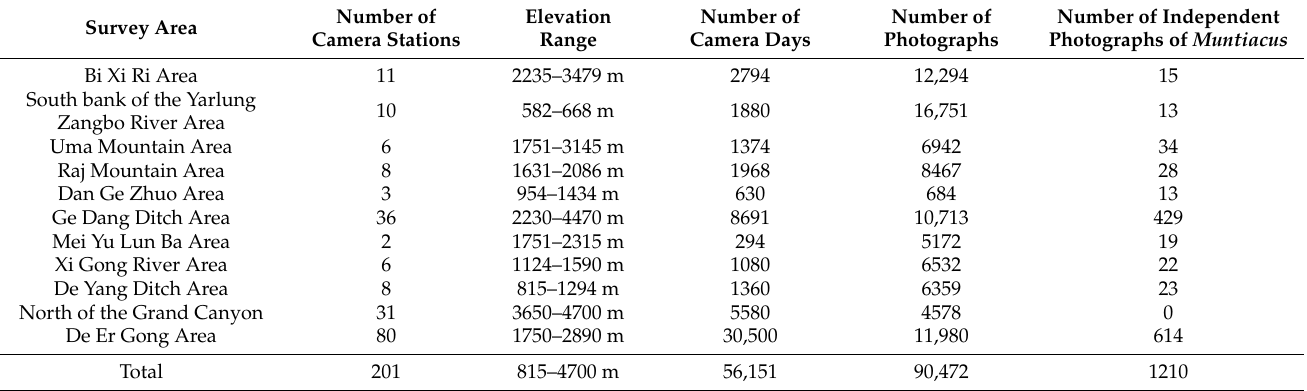
Table 1. Camera trap efforts and number of independent photographs of Muntiacus in the 11 survey areas in the Yarlung Zangbo Grand Canyon National Nature Reserve, Tibet, from 2013 to